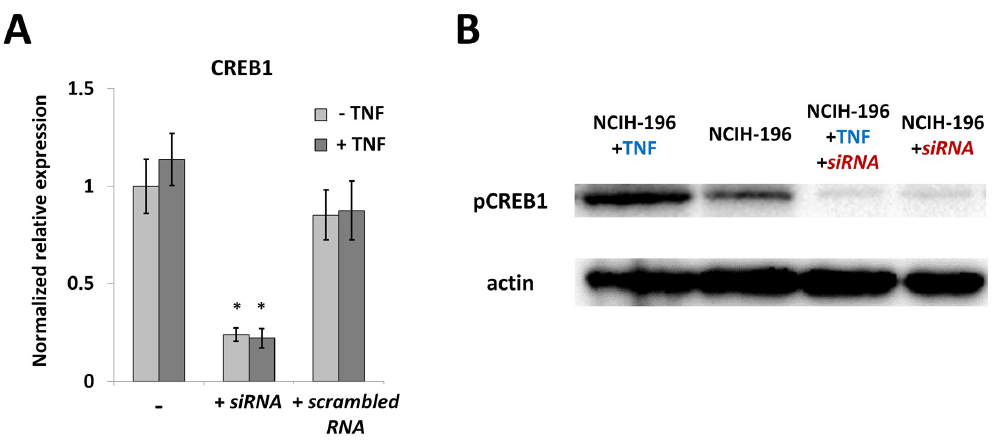
Figure 3. TNF-induced activation promotes phosphorylation of CREB1 in lung cancer cells. Activation by TNF (tumor necrosis factor) (100 ng/mL, 24 h) does not influence the level of CREB1